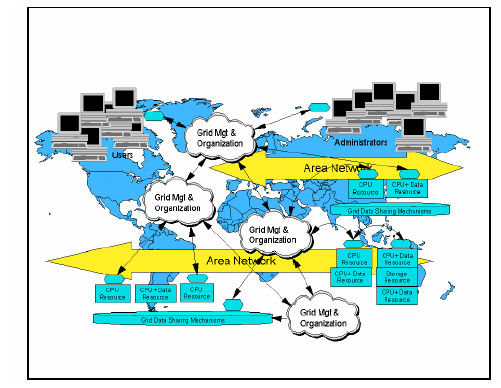
Figure 7: A more complex intergird[8]